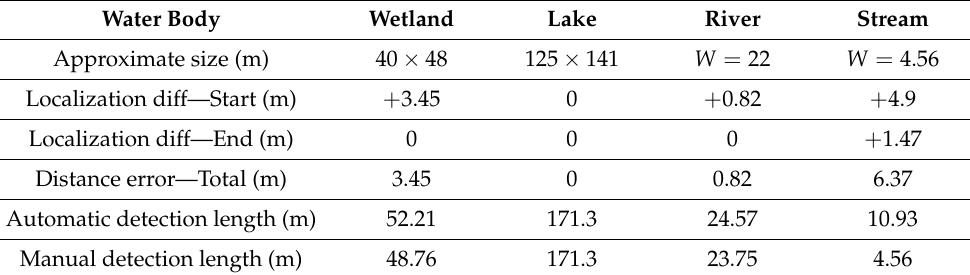
Table 3. Parameters of the detected water body surfaces by satellite PRN 5 trace for 100 s correspond- ing to an area located between ( 50.888837 ◦ N, 1.869701 ◦ E) and ( 50.887512 ◦ N, 1.880296 ◦ E) along the trajectory. Water Body Wetland Lake River Stream Approximate size (m) 40 48 W = 4.56 × Localization diff—Start